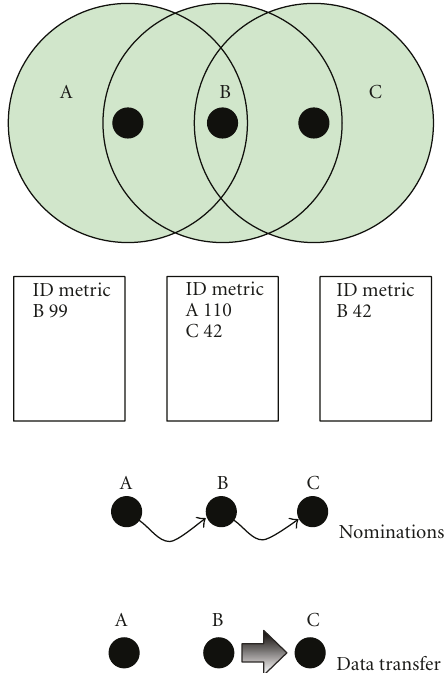
Figure 9: Hidden-station example. Radio range is shown by the shaded circles. Node B can communicate with A and C while A and C cannot communicate. After neighbor discovery, the neighbor tables are filled as shown. A nominates B, B nominates C, and C nominates itself in the election. B ignores A’s nomination and A times out. C accepts B’s nomination. B then sends data to C, and A does not transmit any data during this network wakeup.